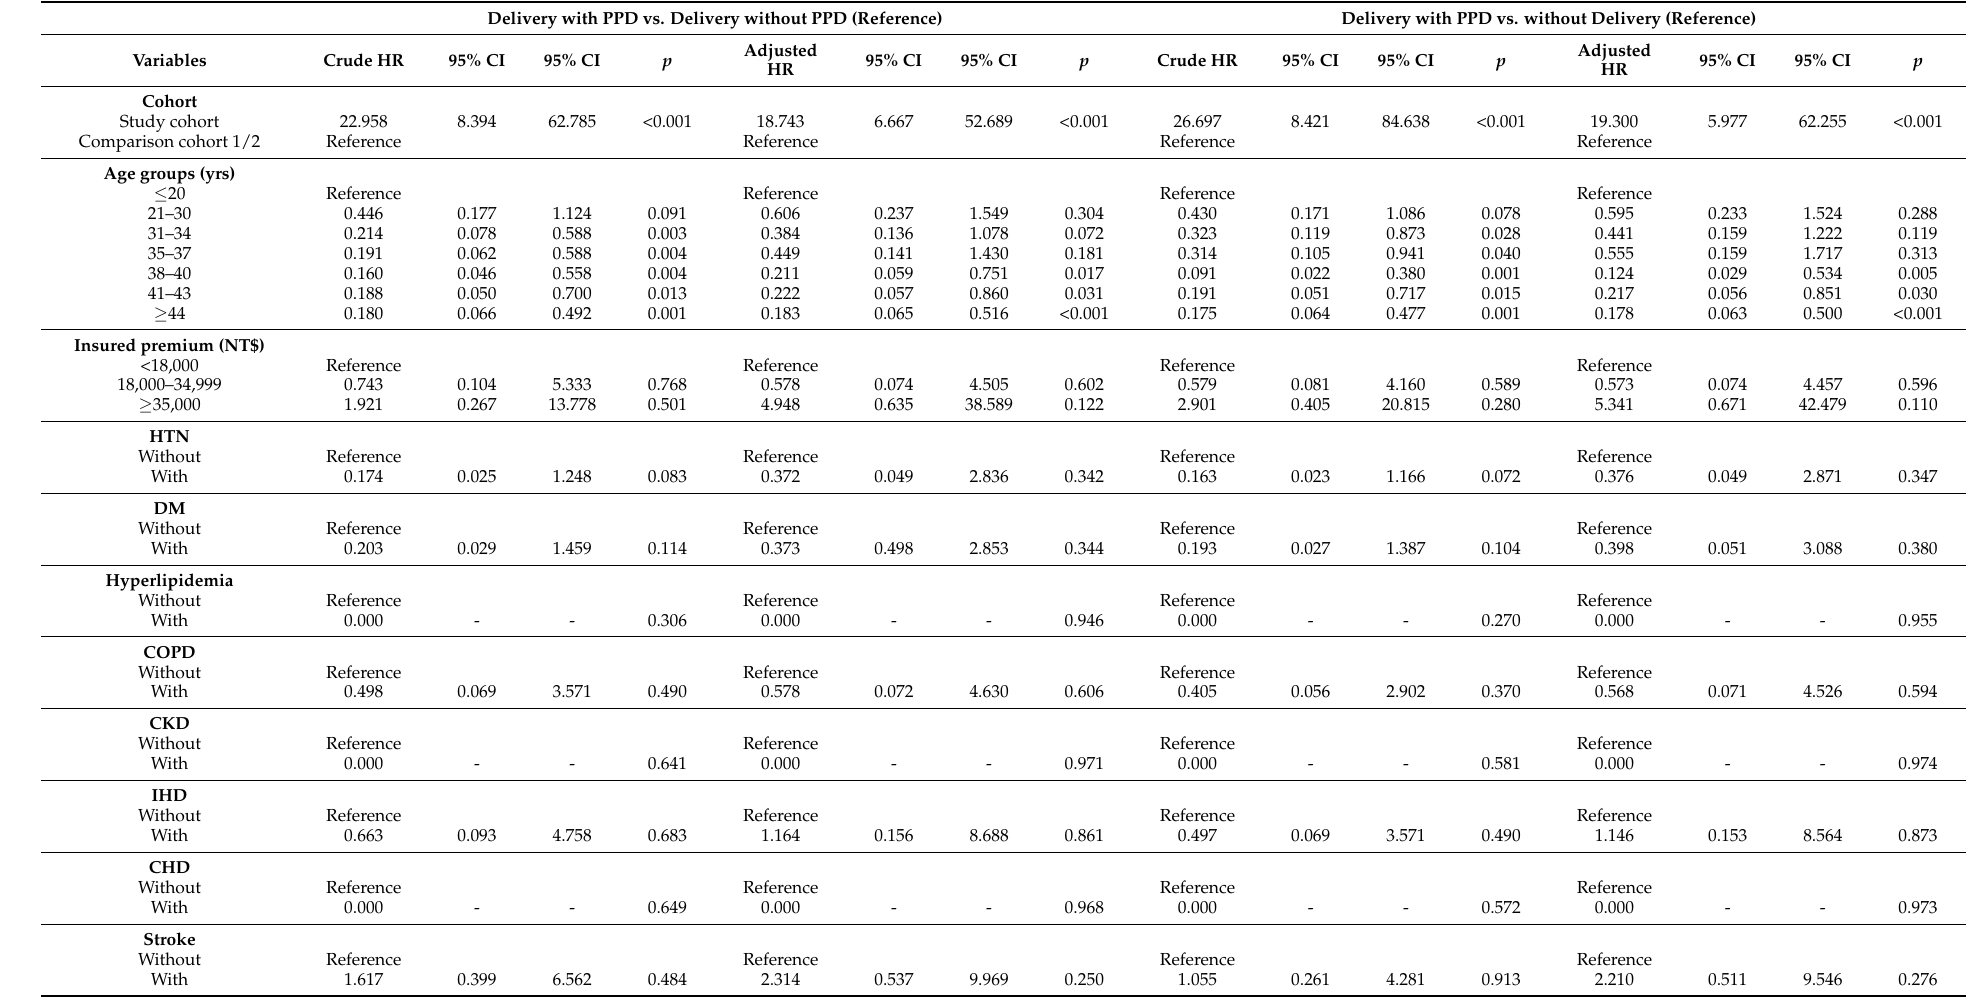
Table 2. Factors associated with suicide by using Cox regression. Delivery with PPD vs. Delivery without PPD (Reference) Delivery with PPD vs. without Delivery